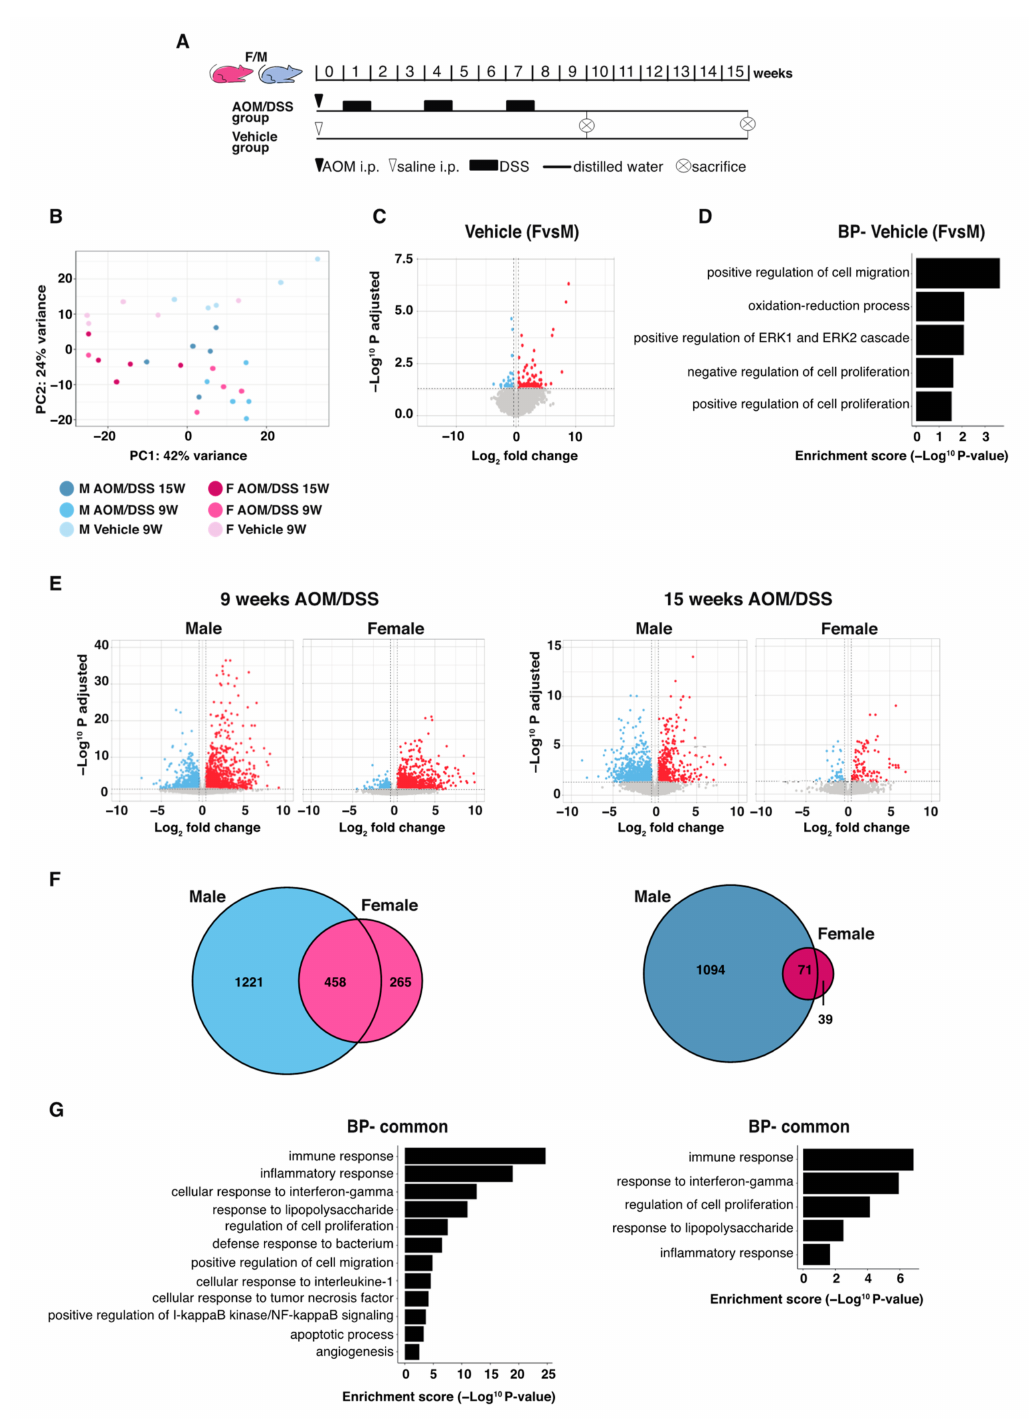
Figure 1. Sex differences in the colon transcriptome. ( A ) Experimental setup: male and female mice underwent treatment with vehicle or AOM/DSS for 9 or 15 weeks. ( B ) PCA plot of vehicle- and AOM/DSS-treated (9 and 15 weeks) male (blue) and female (pink) mice. ( C ) Volcano plot of differentially expressed genes (DEGs) between female and male mice during vehicle treatment. ( D ) BP enrichment analysis of the DEGs between females and males. ( E ) Volcano plots of DEGs between vehicle- and AOM/DSS-treated (9 and 15 weeks) for male ( left ) and female ( right ) mice. ( F ) Venn diagram showing that males responded more strongly to 9 and 15 weeks AOM/DSS treatment, with more DEGs identified, and that both common and sex-specific genes were identified. ( G ) BP enrichment analysis of the common DEGs during 9 (top) and 15 (bottom) weeks of AOM/DSS